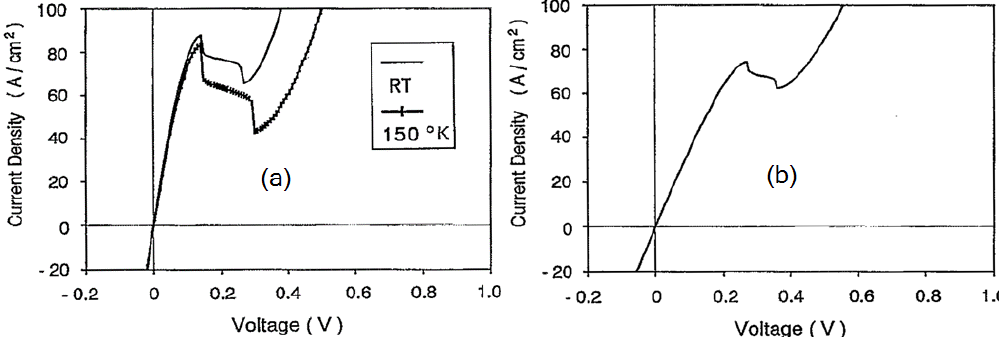
Figure 1. I-V characteristics of the tunnel diodes ( a ) as-grown and ( b ) annealed at 650 ◦ C for 30 min. ( a ) was measured at room temperature and at 150 ◦ K. ( b ) was measured at room temperature